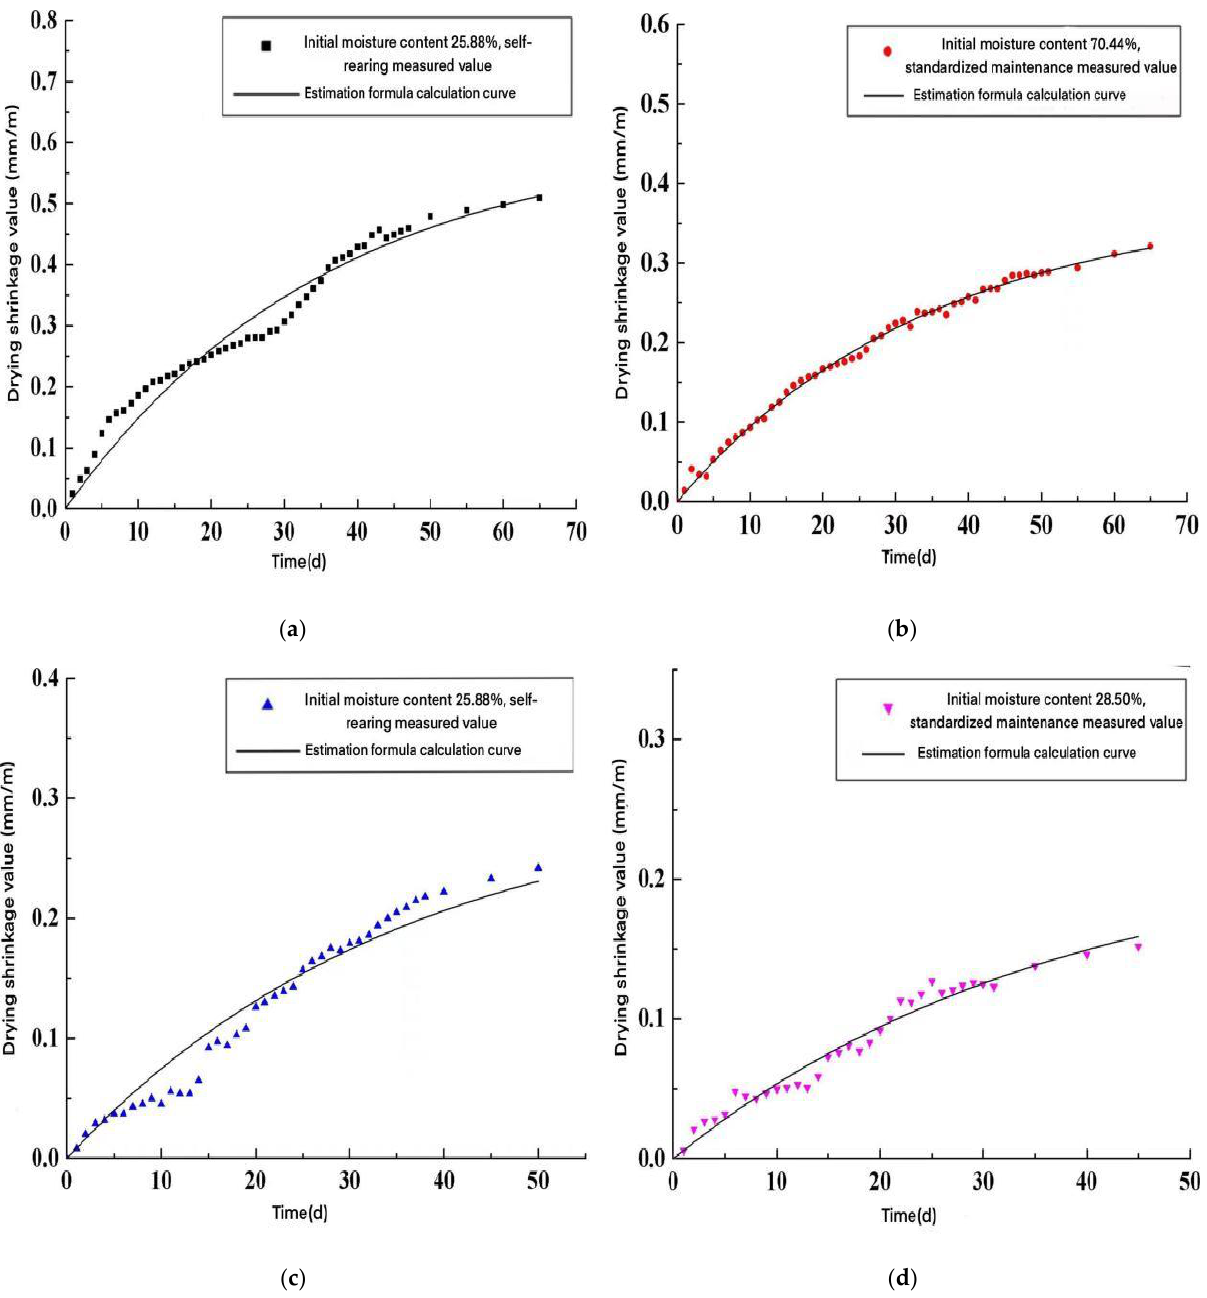
Figure 7. Comparison of the specimen drying shrinkage values and the time-varying model calculation curve. ( a ) Initial moisture content 68.22%, self-sustaining; ( b ) initial moisture content 70.44%, standard raising; ( c ) initial moisture content 25.88%, self-sustaining; and ( d ) initial moisture content 28.50%, standard raising.